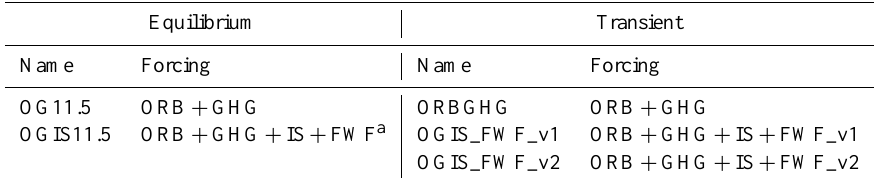
Table 2. Experiments and corresponding